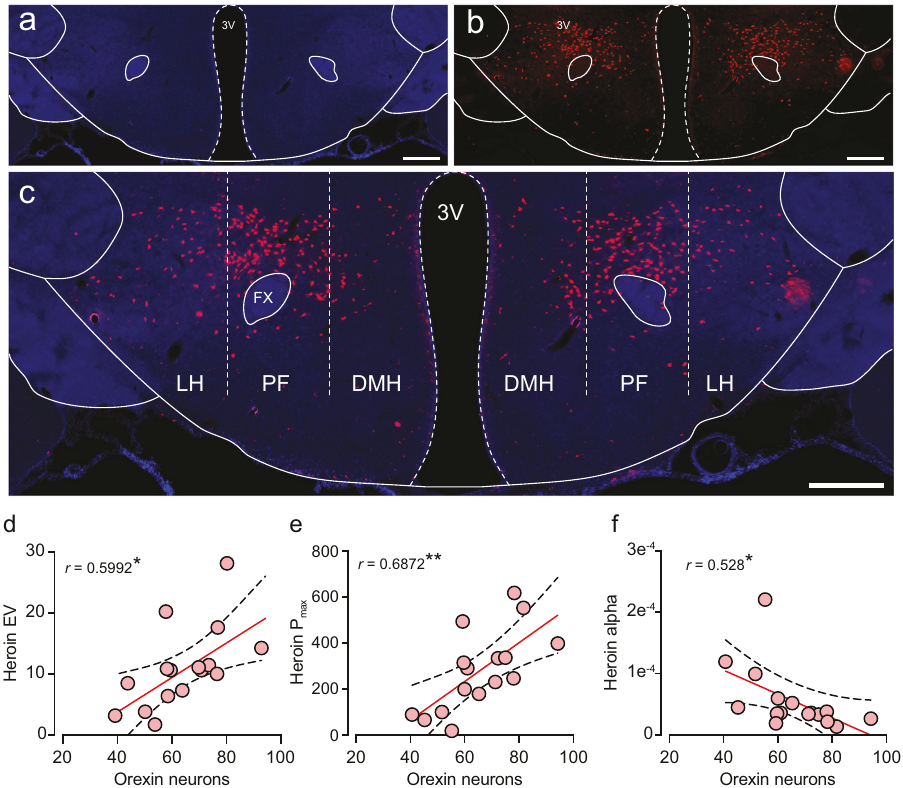
Fig. 5 The number of orexin neurons in the lateral hypothalamus correlates with behavioral economics indicators of heroin motivation. a Representative images of the neuronal stain (DAPI), b orexin immuno fl uorescence, and c the overlay are shown, depicting the anatomical boundaries between lateral hypothalamus (LH) versus the dorsomedial (DMH) and perifornical (PF) regions (3V third ventricle, FX fornix. Scale bar = 500 µm). The number of LH orexin neurons positively correlated with heroin EV ( d ) and P max ( e ), and negatively correlated with heroin α ( f ). This pro fi le implicates the LH orexin system as a driver of the heroin motivational state. * p < 0.05, ** p < 0.01 signi fi cant correlation. elasticity. In this domain, previous studies have demonstrated positive correlations between cocaine or heroin EV and drug choice, and negative correlations between food or saccharin EV and drug choice [59, 62]. In the present study, heroin choice did not correlate with any behavioral economics variables, indicating that these are fundamentally separate metrics of OUD severity. Furthermore, heroin EV was higher than food EV, whereas previous studies have found food or saccharin EV to be higher than drug (cocaine or heroin) EV [59, 62]. Consistent with our prior work [6], food α was higher than heroin α , again pointing to a